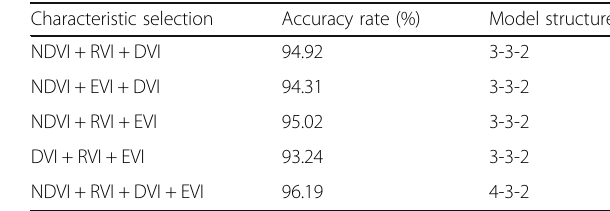
Table 4 Different characteristics combination